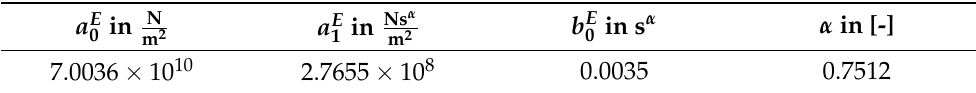
Table 7. List of the fractional derivative